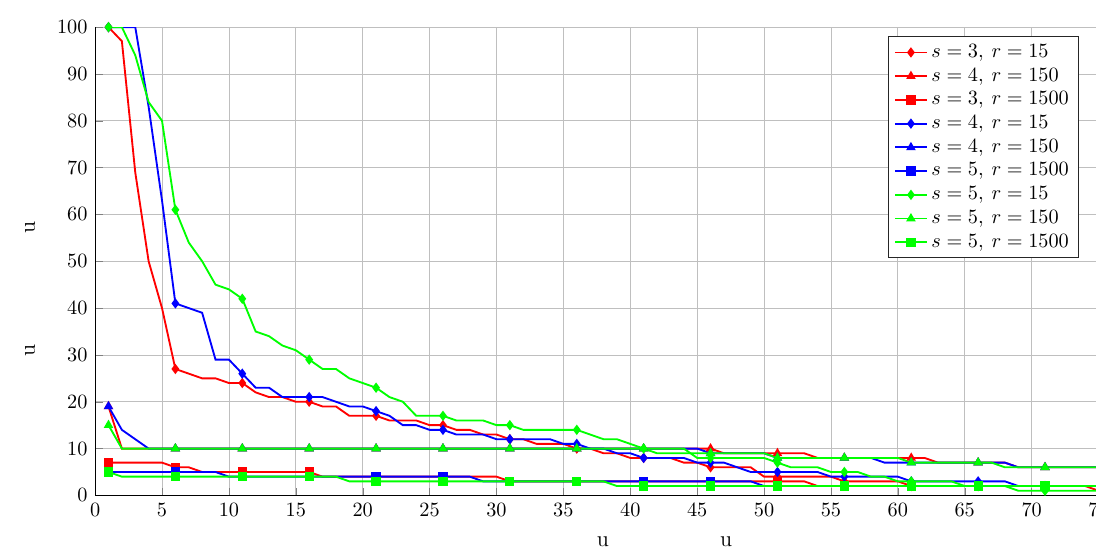
regions (sorted after number of occurrences) Figure 5. Number of occurrences for a region (sorted in descending order, clipped at the 75th